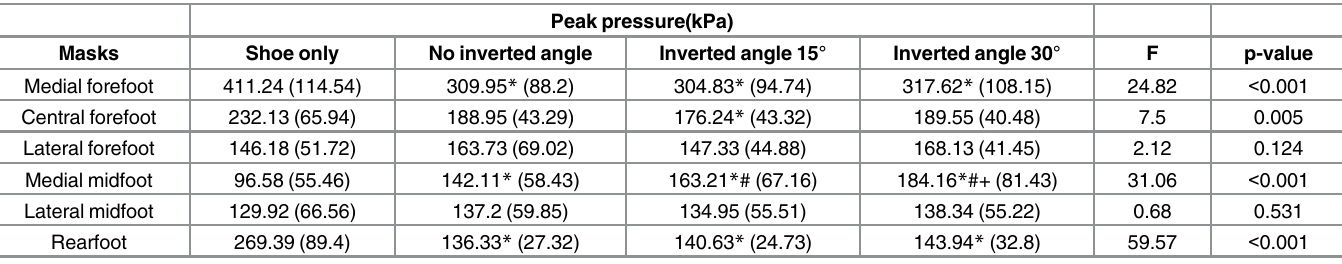
Table 2. Peak pressures at the 6 mask areas in each foot orthotic